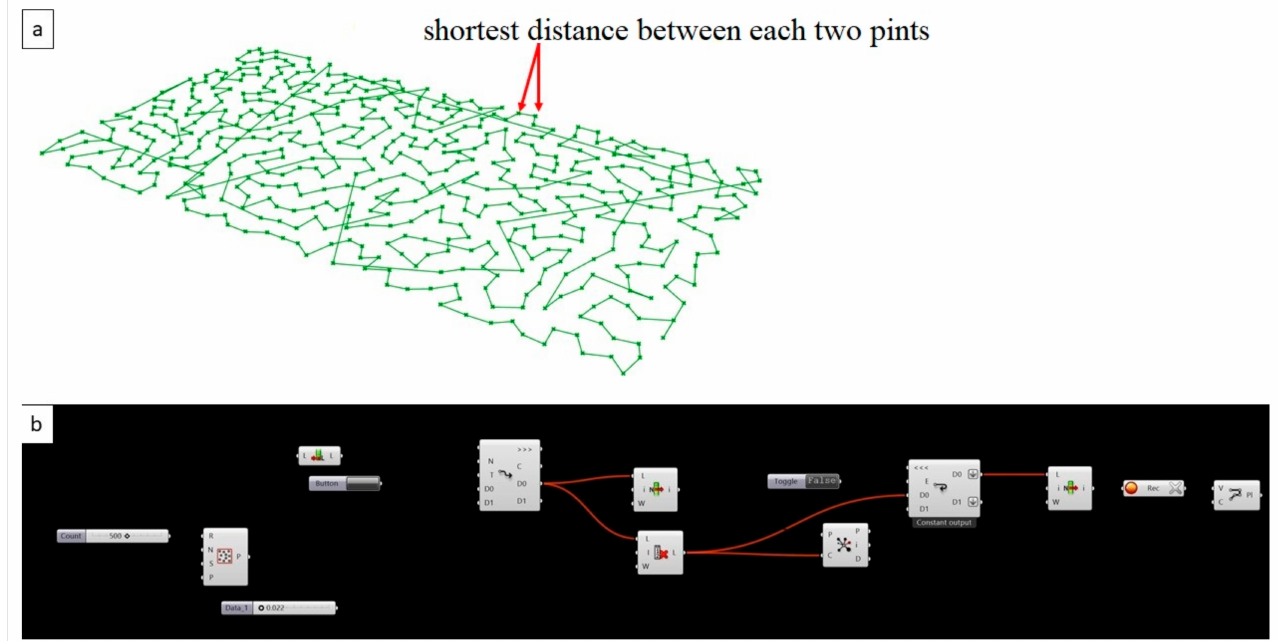
Figure 4. The shortest path algorithm in Grasshopper Anemone that was employed to connect the resultant latest points in the reaction–diffusion system based on the hydrophilic nature of clay. This proves the structural coherence of the bricks’ design by minimizing the span between every two points while also minimizing the material consumption due to the accurate distributed material deposition where needed. ( a ) the resultant shortest path diagram of the connected points that were the last to absorb water in the volume of a conventional Catalan brick, and were resulting from the first step simulation of reaction diffusion, ( b ) the grasshopper algorithm of the shortest path logic that was applied to connect the result points from the first step simulation, in order to find the shortest distance between these points to minimize the span between them to achieve distributed load and minimum material deposition as well. Images by the